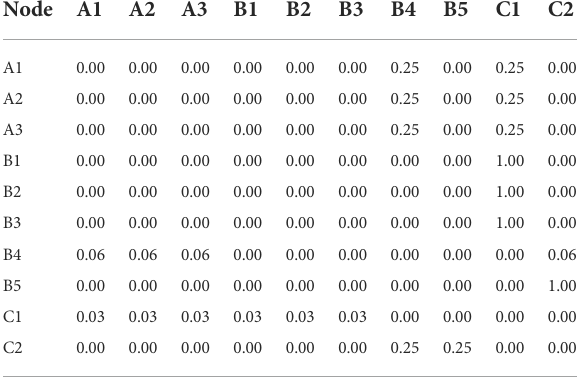
TABLE 11 Constraint between any two nodes. Node A1